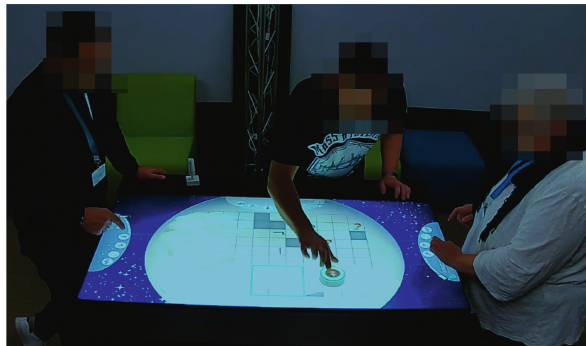
Figure 7: An example of “same problem” style (SP): P2 (middle) of G2 is actively interacting with the system using the drone. P1 and P3 are closely following his action, commenting on the observed activities, and are ready to move the rover towards the target cell. They are all working on the same problem.